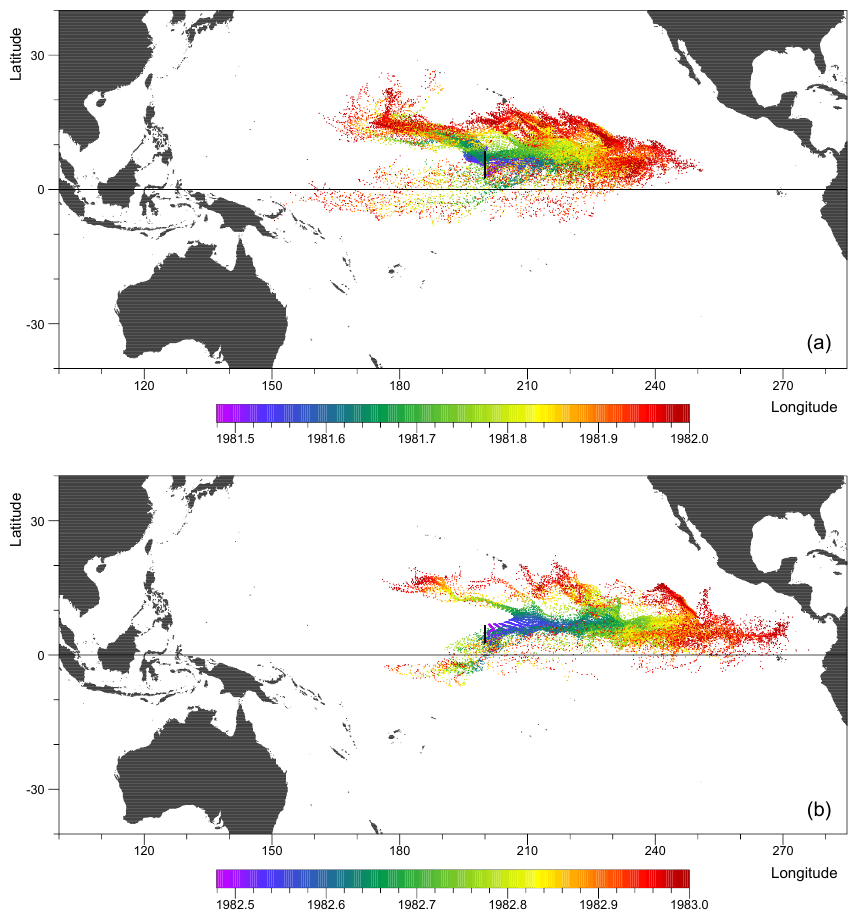
Figure 26. Water particle positions plotted every 5 days, starting from 24 June (a) 1981 and (b) 1982, and running to the end of the year. The date is denoted by the colour of each dot. For the initial state, one particle was placed at the centre of each model grid cell lying along the black line, having a water temperature greater than (a) 27.8 ◦ C and (b) 29 ◦ C, there being no water with a temperature greater than 29 ◦ C along the line in